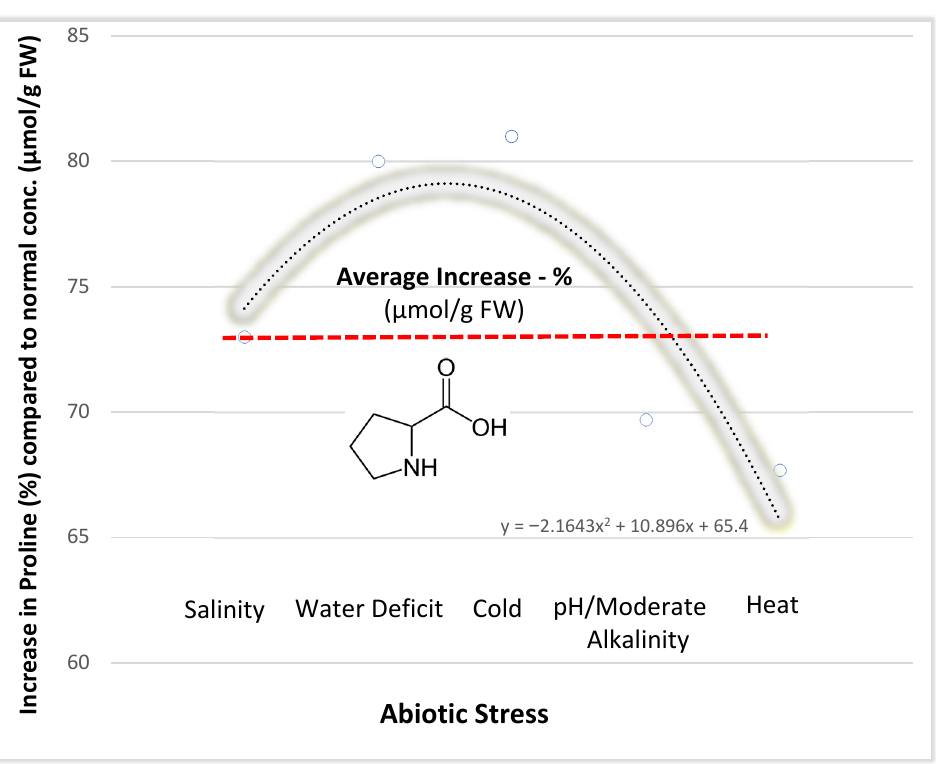
Figure 4. Summarizing data from recent Web of Science (1980–2020) articles on the average proline accumulation in staple wheat crops induced by individual abiotic stresses/climate-change-associated factors such as water deficit, salinity, pH, cold and heat. (Data retrieved on 10 June 2022).